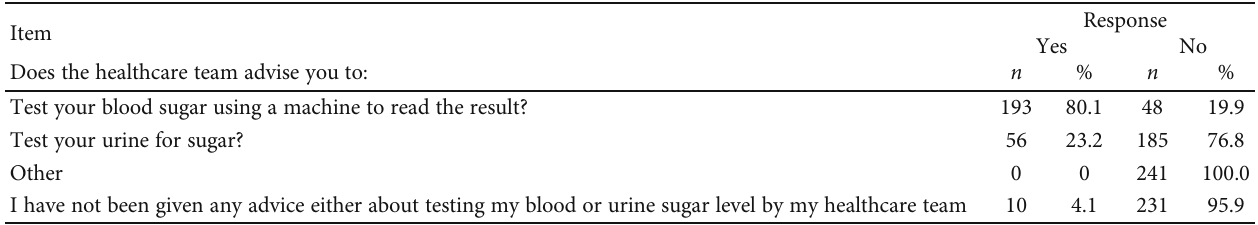
Table 5: Response to the extended SDSCA survey sugar monitoring domain.